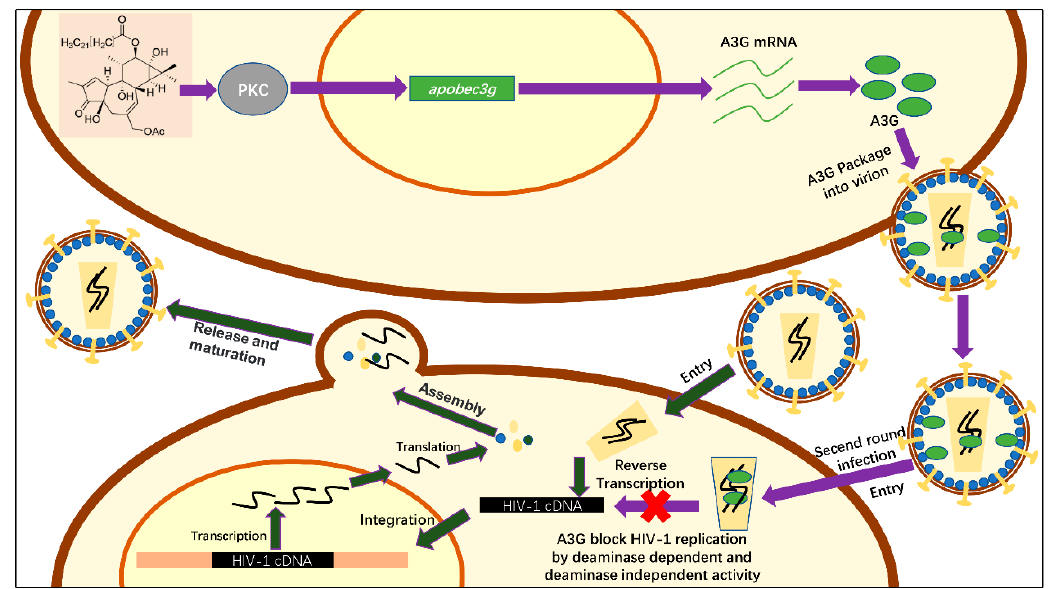
Figure 7. Schematic of the anti-HIV-1 activity mechanism of hop-8. The process shown with deep green arrows represents a simple schematic of HIV replication. Hop-8 stimulates A3G expression via the PKC pathway. A3G is packaged into the progeny virions and restricts the replication of the progeny virions (shown with purple arrows).